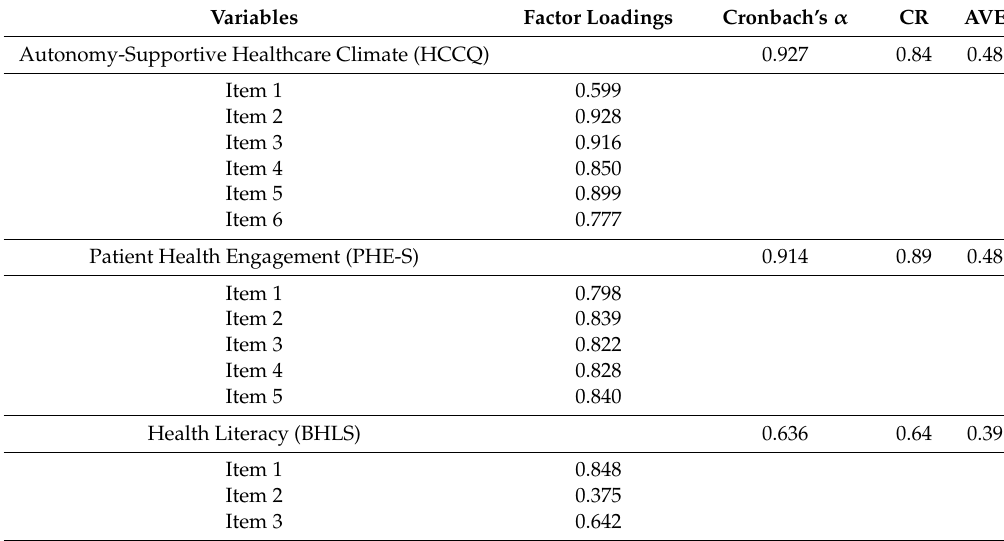
Table 4. Measurement